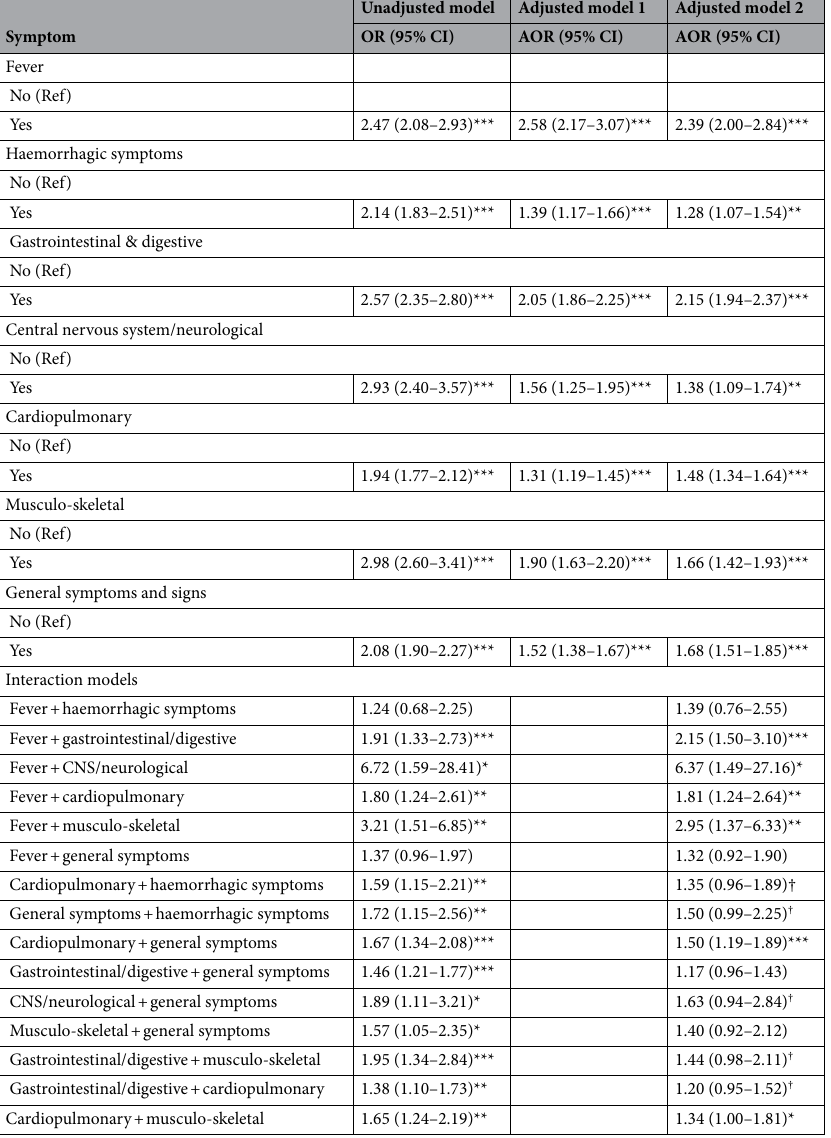
Table 4. Logistic regression models predicting case positivity by clinical symptoms and signs among suspected Lassa fever cases in Nigeria 2018–2021. Model 1 adjusted only the symptoms; model 2 adjusted the symptoms and the socio-demographic characteristics of the cases, and time variables. Other interactions were neither statistically significant in both the unadjusted and adjusted models. ***p < 0.001; **p < 0.01; *p < 0.05. † The adjusted models reached statistical significance (p < 0.05) when fever is not